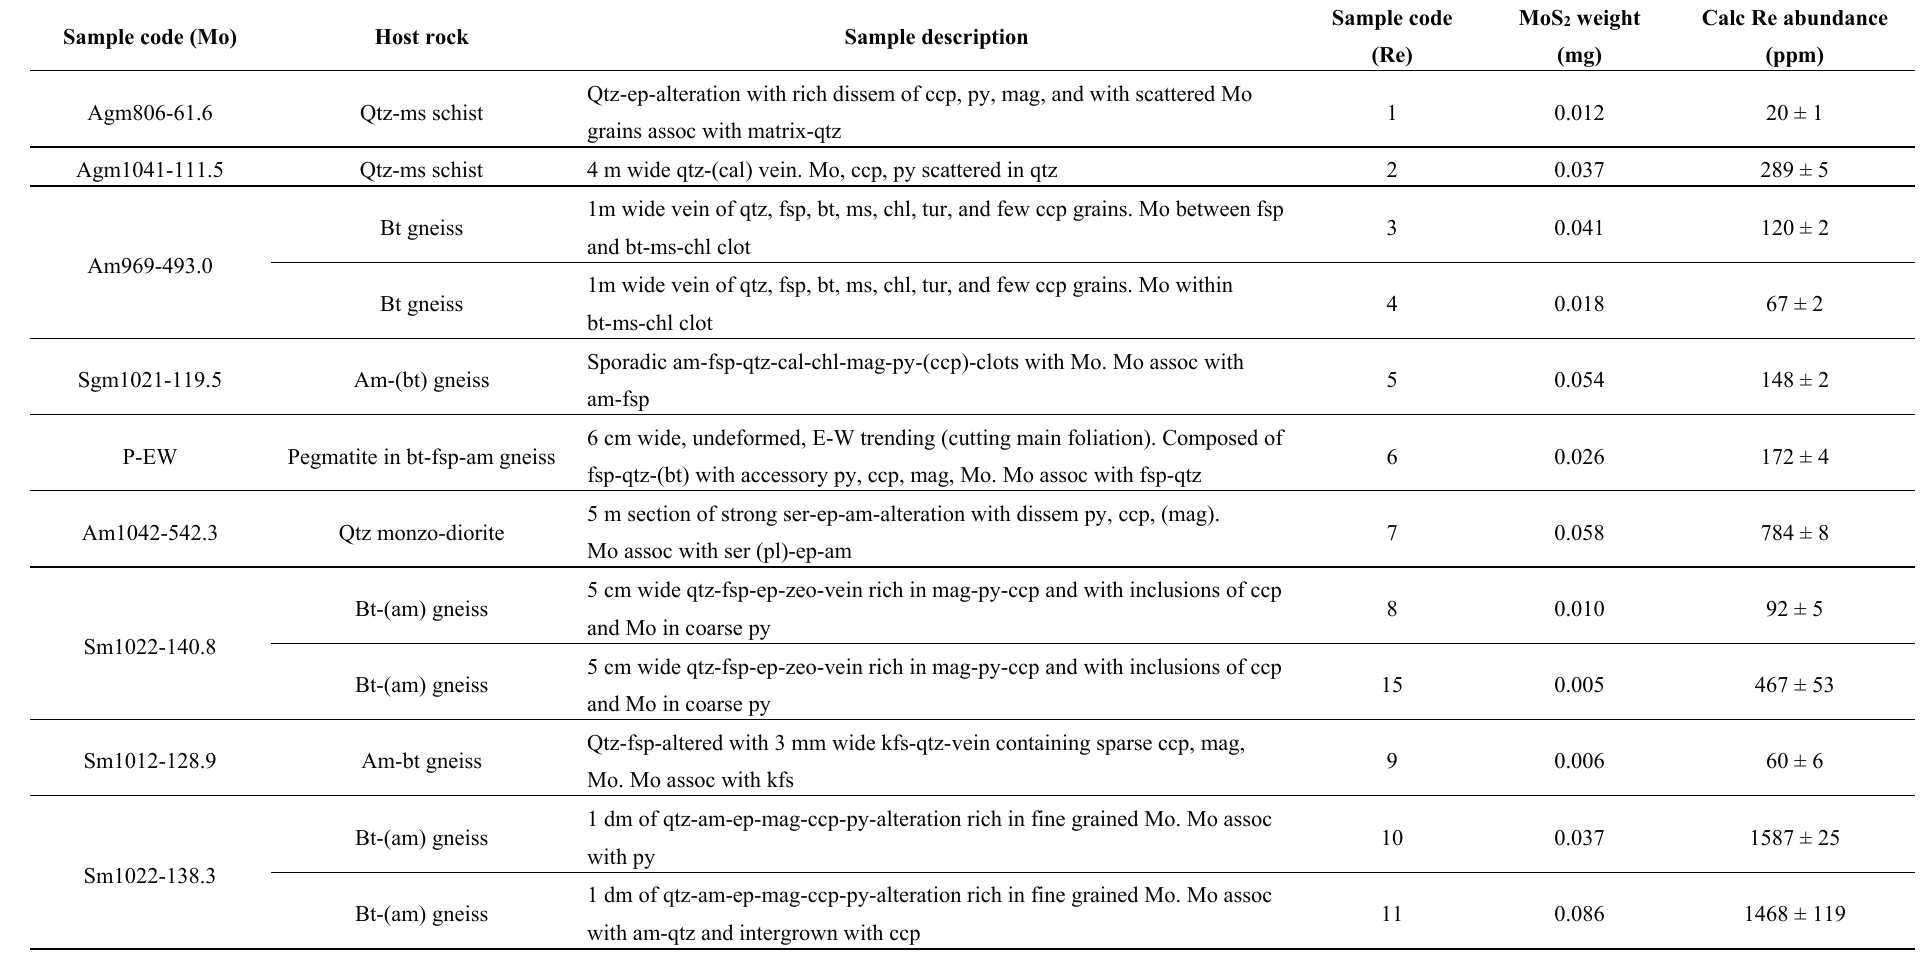
Table 1. Rhenium concentration of molybdenite grains. Mineral abbreviations listed in